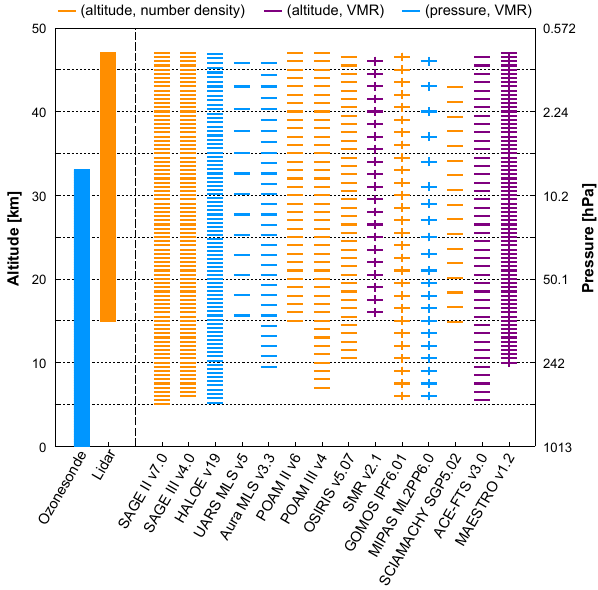
Figure 1. Overview of the native representation of the ozone profile records (see legend). A vertical band defines the approximate range for the ground-based data sets, while individual levels are shown for satellite profiles. Only the levels considered in our analyses are de- picted. Profile-dependent vertical grids are marked with small ver- tical bars. Differences between geometric and geopotential height are